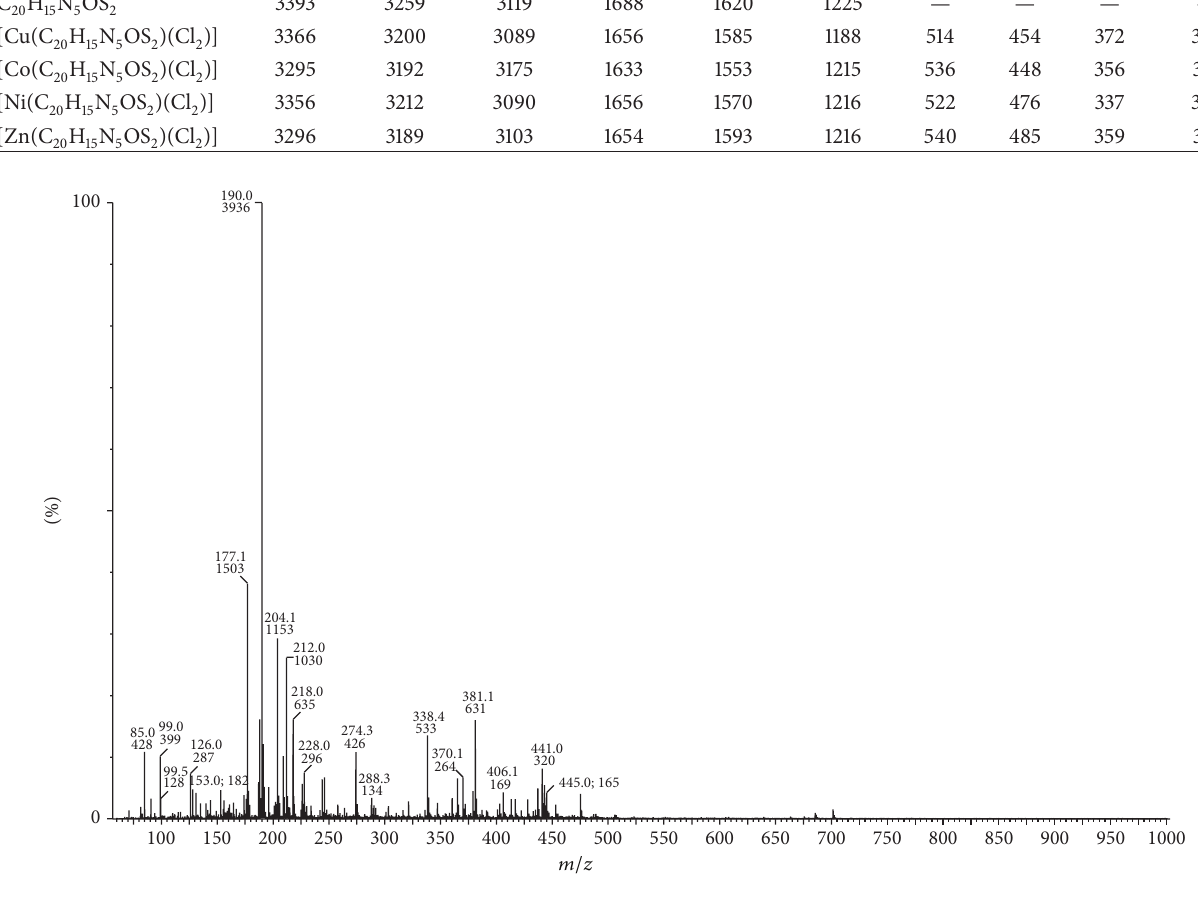
Figure 1: ESI mass spectrum of Schiff base ligand (L)